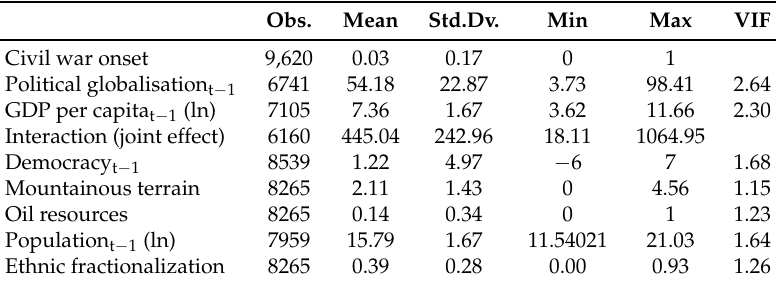
Table 1. Summary